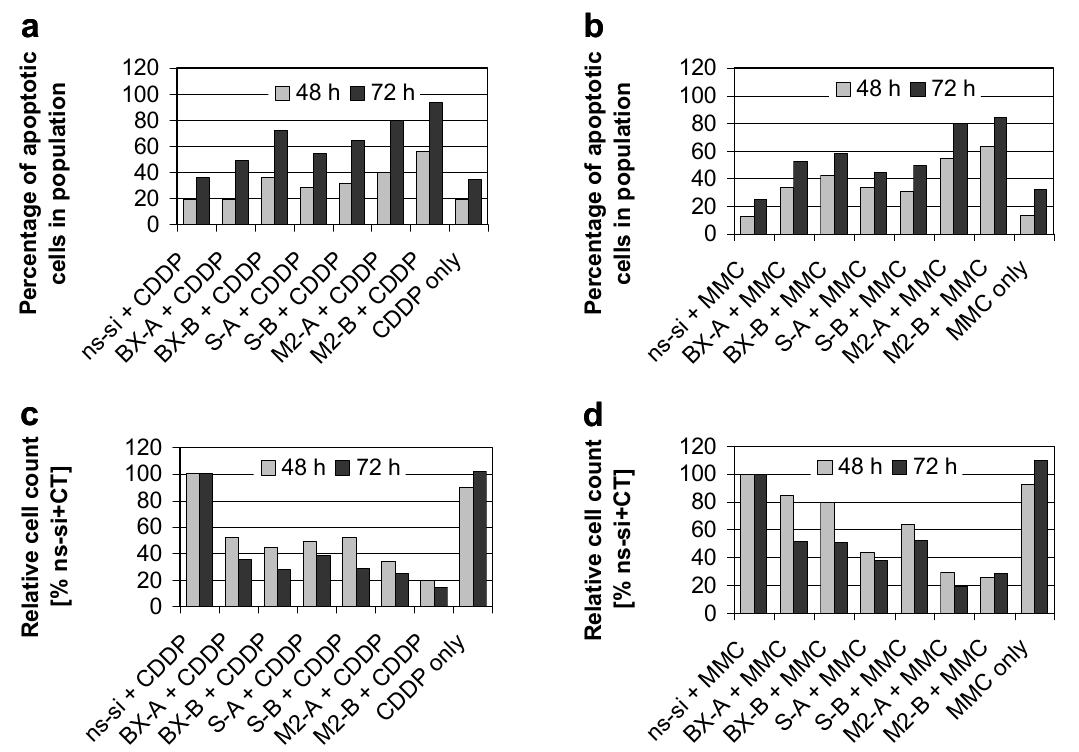
Figure 5. Induction of apoptosis and reduction in cell counts after combined siRNA plus chemotherapy (CT) treatments in EJ28 bladder cancer cells. Cells were transfected with the respective siRNAs for four hours. “CT only” cells were treated with serum-free OptiMEM medium during transfection. Twenty-four hours after transfection start, cells were treated with 2.1 µg/mL cisplatin for 24 h ( a , c ) or with 0.9 µg/mL mitomycin C for 2 h ( b , d ). Rate of apoptosis—presented as sum of early and late apoptotic cells—( a , b ), as well as cell counts ( c , d ) were determined 48 h and 72 h after transfection start.